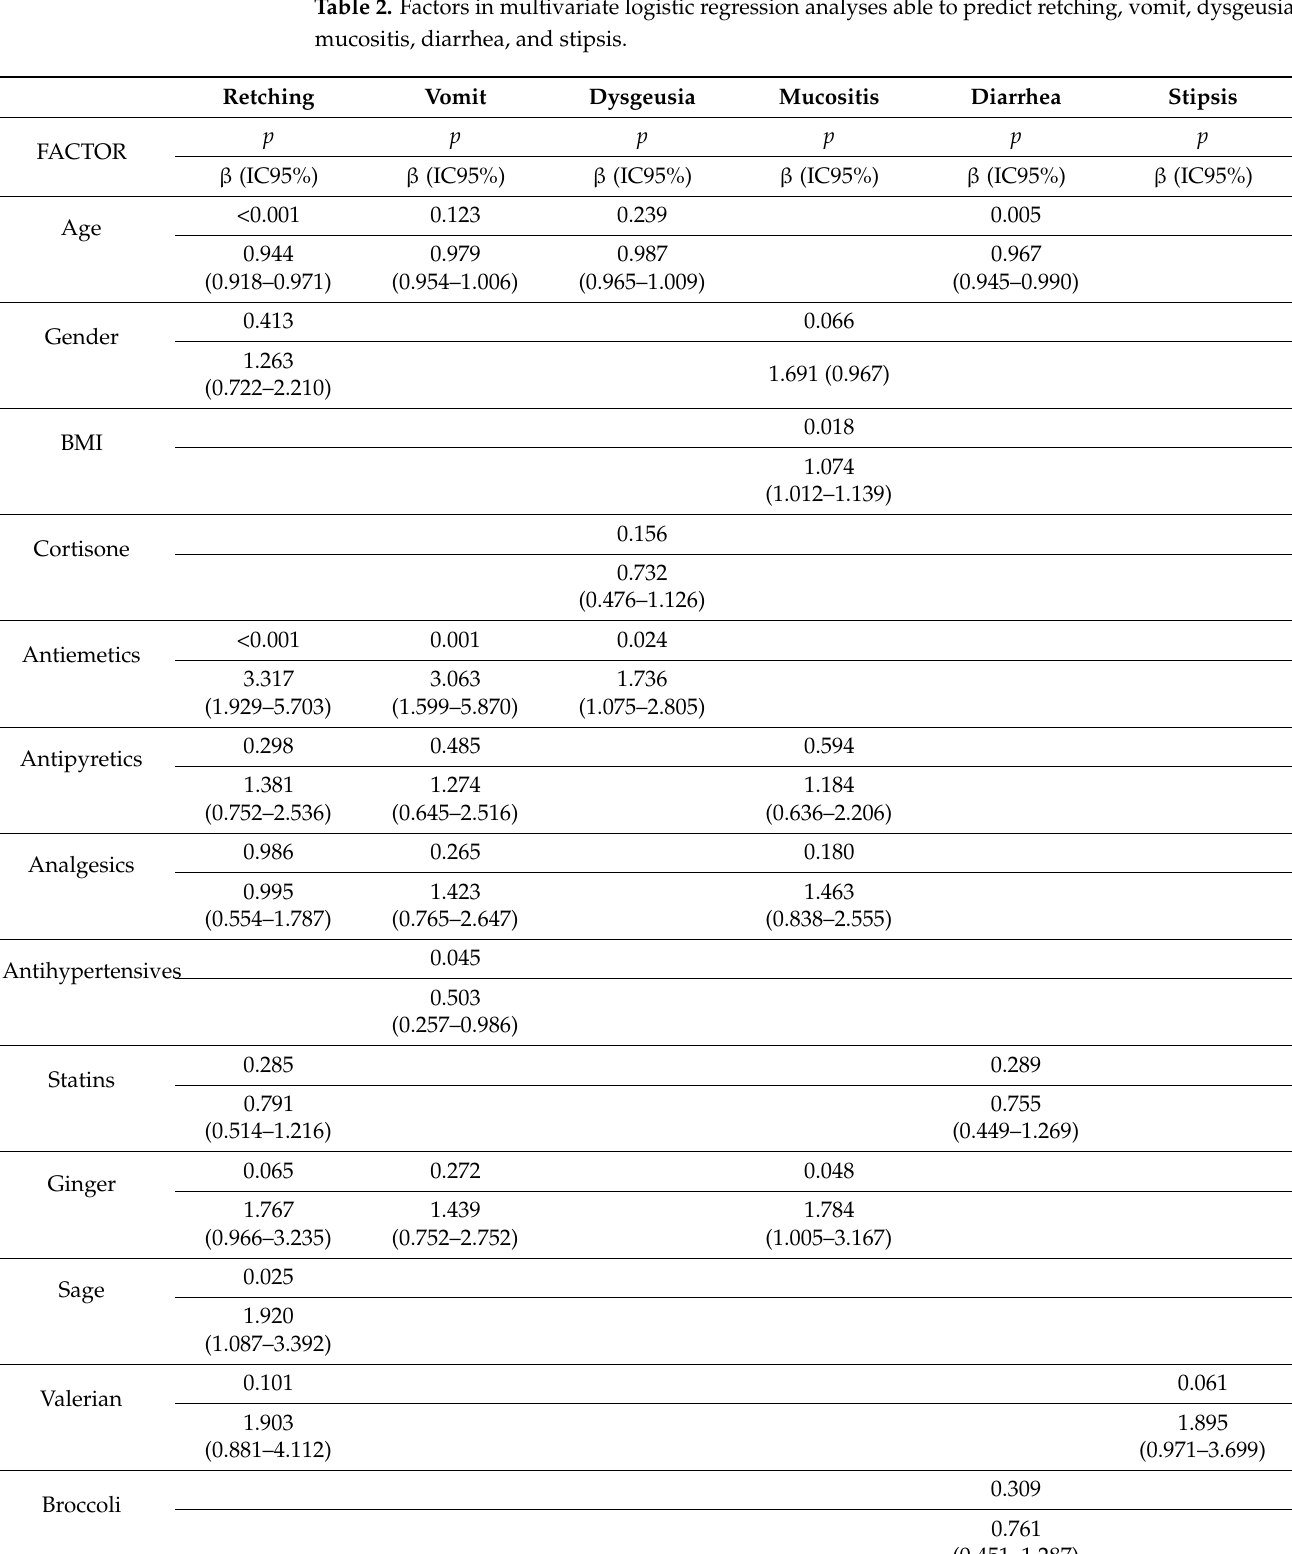
Table 2. Factors in multivariate logistic regression analyses able to predict retching, vomit, dysgeusia, mucositis, diarrhea, and